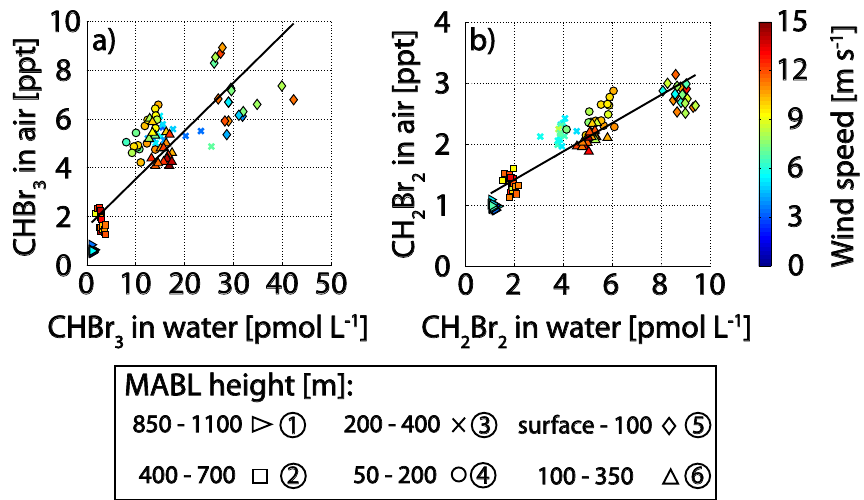
Fig. 11. Correlations of oceanic versus atmospheric halocarbons (CHBr 3 in a and CH 2 Br 2 in b ) filled with wind speed (see color coding). The black line indicates the regression line for the whole cruise. For the individual correlation coefficients see Table